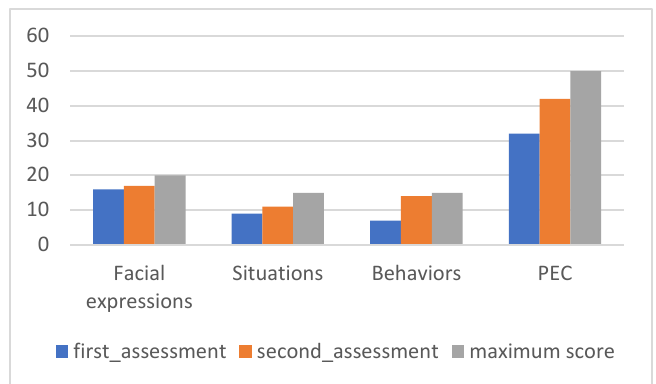
Figure 6. Tomás’s PEC results. Figure 6. Tom á s’s PEC